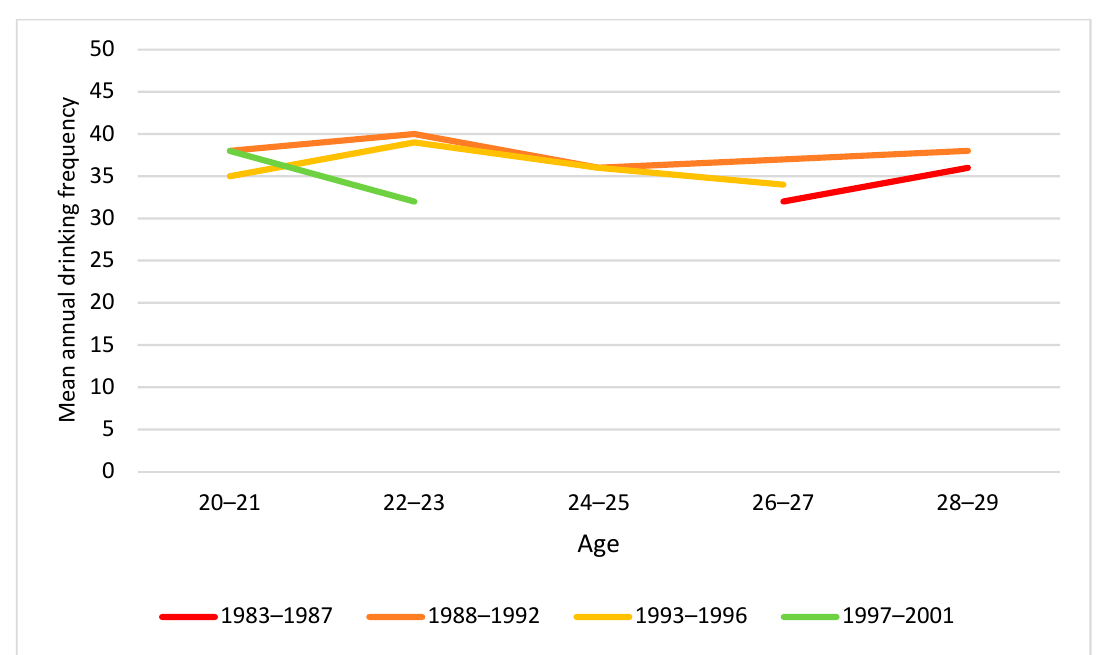
Figure 8. Mean annual drinking frequency by birth cohort and age. Note: None of the cohort differences at any age were statistically significant ( p > 0.05).